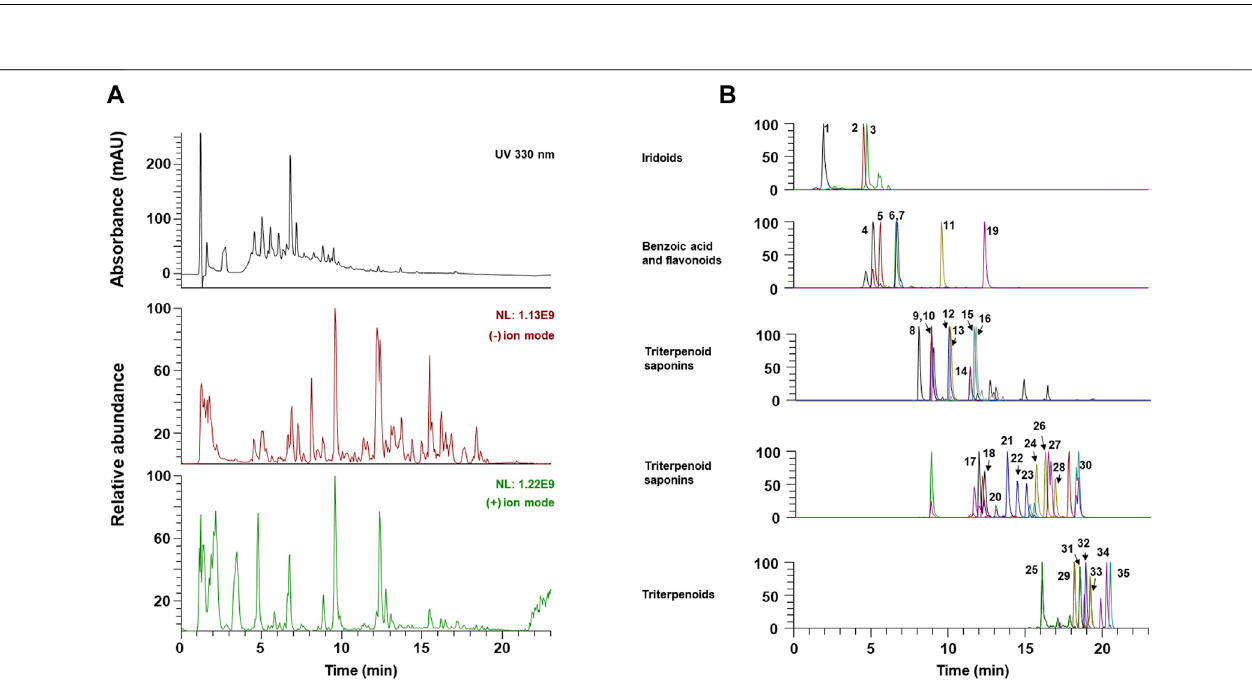
FIGURE5| TheUPLC-MS/MSchromatogramsofOCD20015-V009identi fi edphytochemicals. (A) UVchromatogramandtotalionchromatogramofOCD20015- V009. (B) The PRM chromatogram of OCD20015-V009.